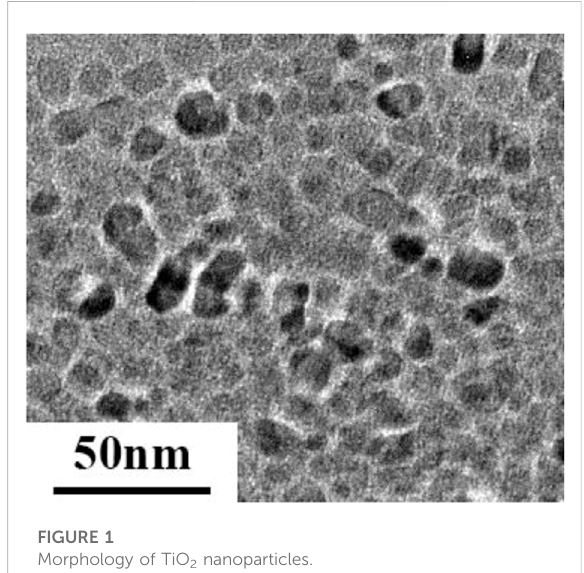
FIGURE 1 Morphology of TiO 2